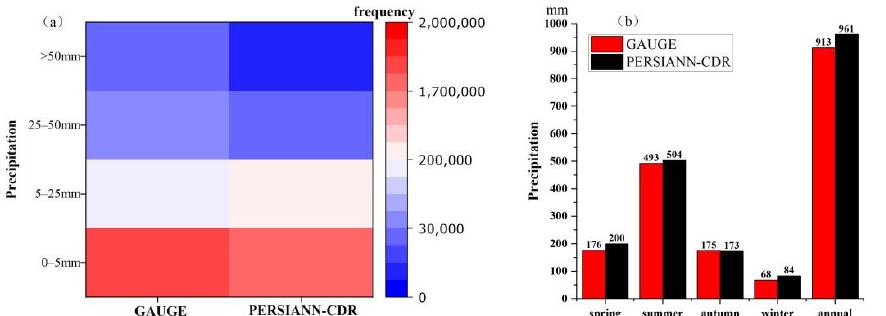
Figure 5. Comparison between PERSIANN ‐ CDR estimates and gauge observations of ( a ) daily pre ‐ cipitation frequency in different magnitudes and ( b ) precipitation amounts in different seasons.